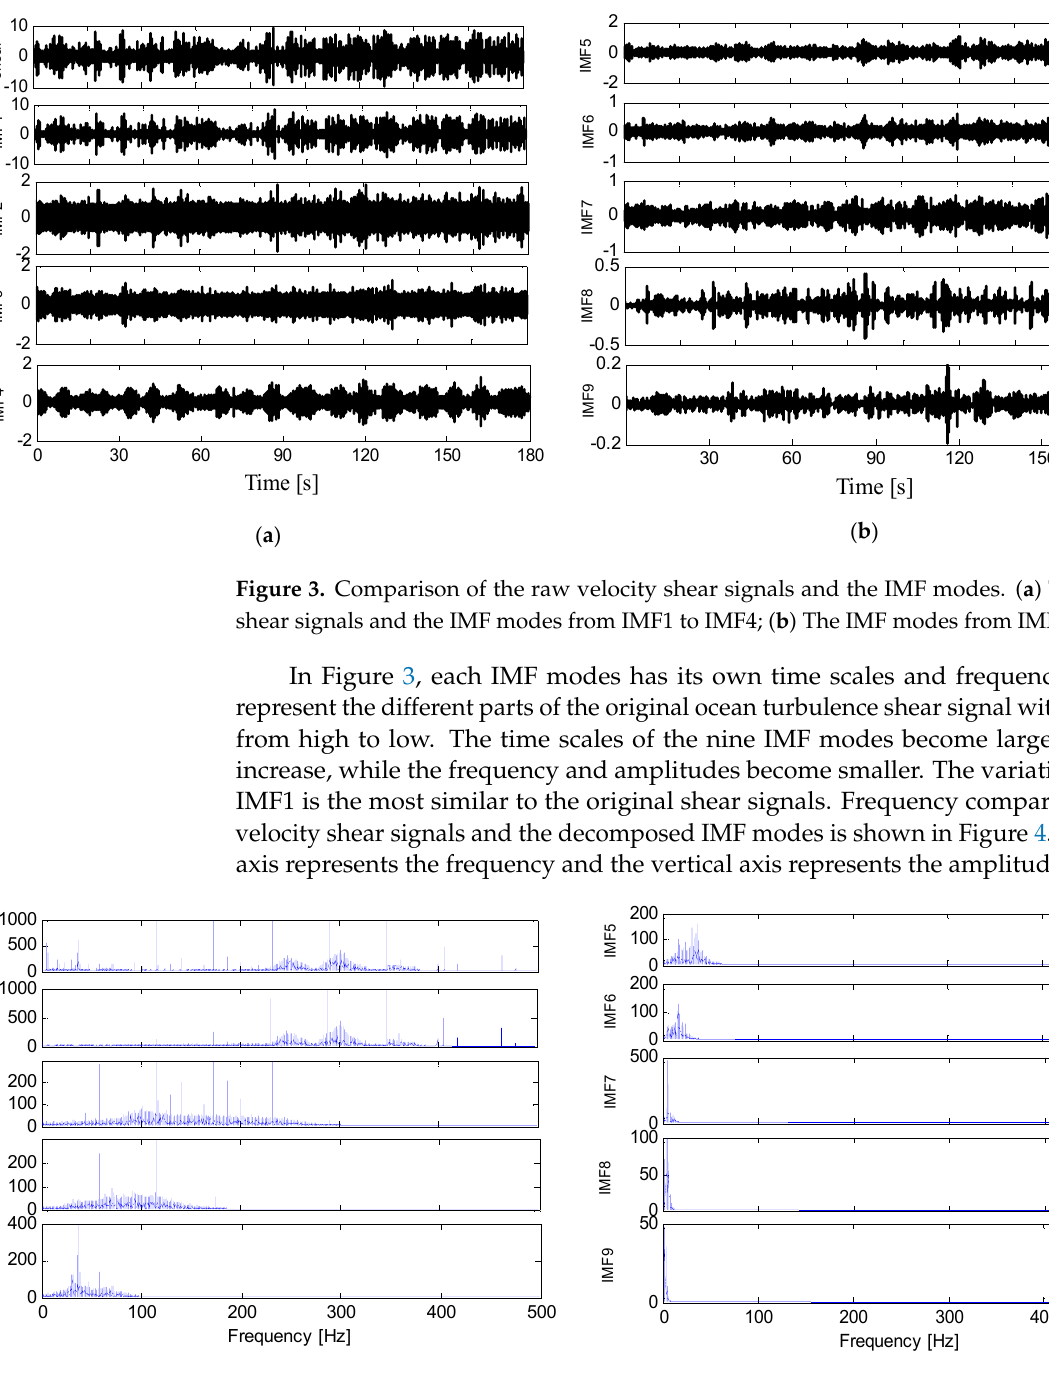
before denoising after denoising